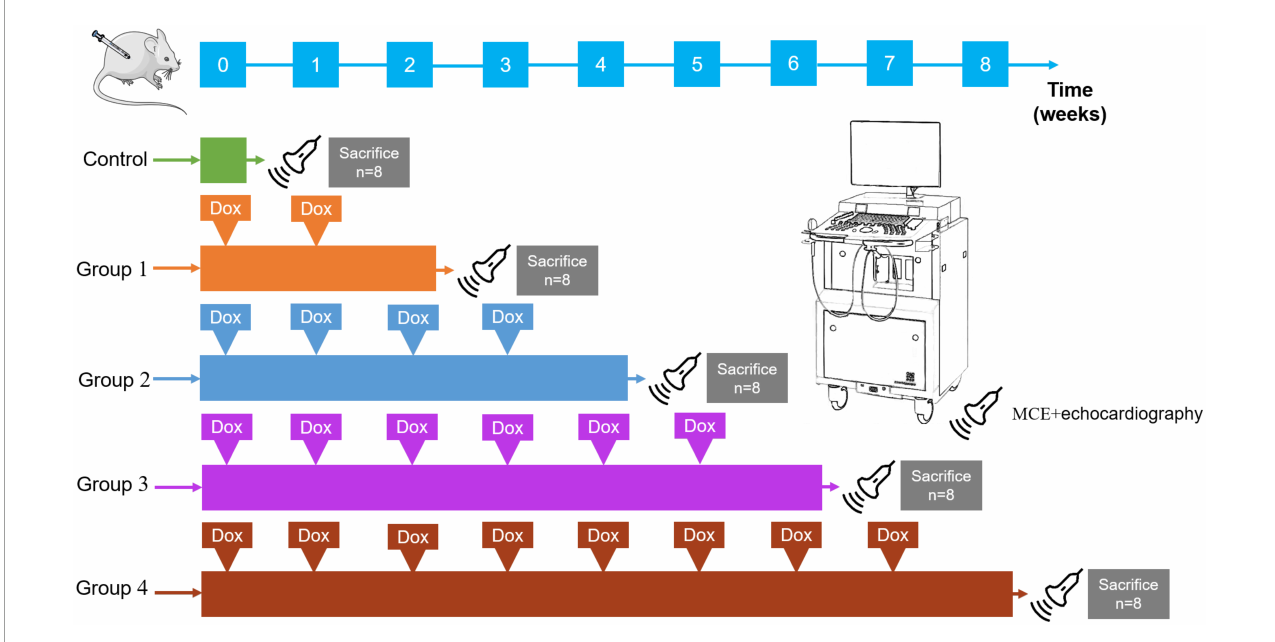
FIGURE1 Study design. Rats received intraperitoneal DOX (2.5 mg/kg, once a week). Forty rats were randomly divided into the following five groups (8 rats in each group); control: 8 rats received normal saline; Group 1: 8 rats received two intraperitoneal injections of DOX; Group 2: 8 rats received four intraperitoneal injections of DOX; Group 3: 8 rats received six intraperitoneal injections of DOX; Group 4: 8 rats received eight intraperitoneal injections of DOX. MCE and echocardiography scans (probe) were performed in the long-axis planes in each group. All rats were sacrificed for a histopathologic evaluation immediately after the ultrasonic